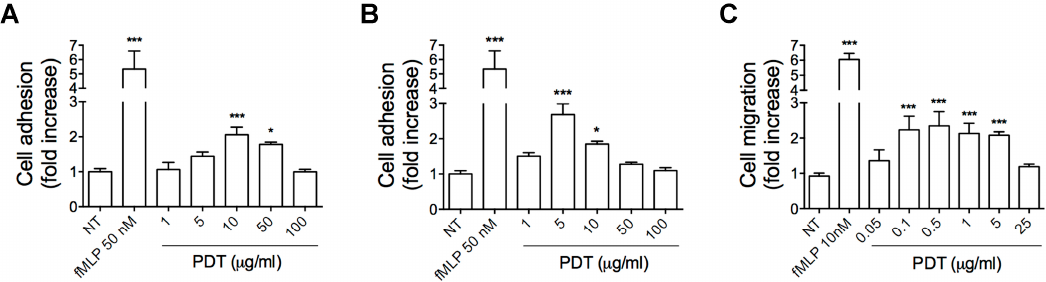
Figure 2. Effect of PDT on monocytes adhesion and migration. (A, B) Static adhesion assay on ICAM-1 ( A ) and VCAM-1 ( B ). Monocytes were stimulated or not (NT) for 2 min at 37 °C with PDT at the indicated concentrations. Bars represent the means ± SD of 3 independent experiments performed in triplicate. Statistical analysis was performed by one-way ANOVA and the Bonferroni’s post-test was used to compare data, *** p < 0.001, * p < 0.05. ( C ) Transwell migration assays of monocytes in response to the indicated treatments. Bars represent the means ± SD of 3 independent experiments performed in triplicate. Statistical analysis was performed by one-way ANOVA and the Bonferroni’s post-test was used to compare data, *** p < 0.001. NT = not treated.